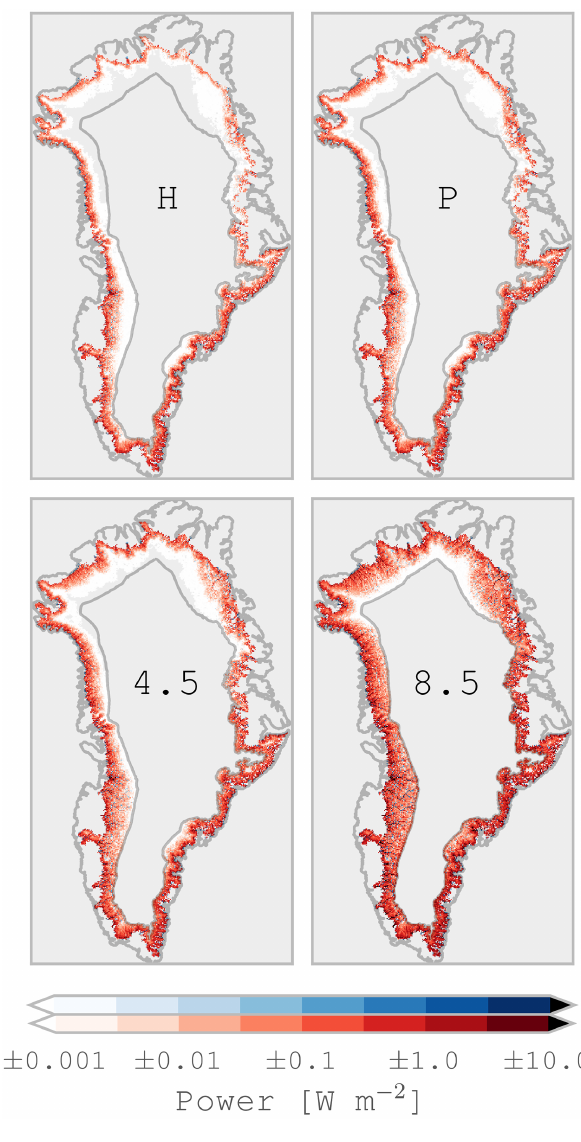
Figure 3. Heat released at the bed due to VHD. Labels are the same as in Fig. 1. Color bars represent heating (red, positive) and cooling (blue, negative). Gray contours mark 0 and 2000m